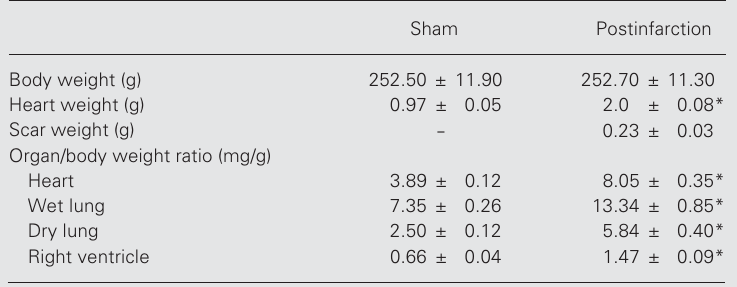
Table 1. Characteristics of cardiac hypertrophy and heart failure in rats submitted to induction of a large infarct, compared to sham-operated animals.